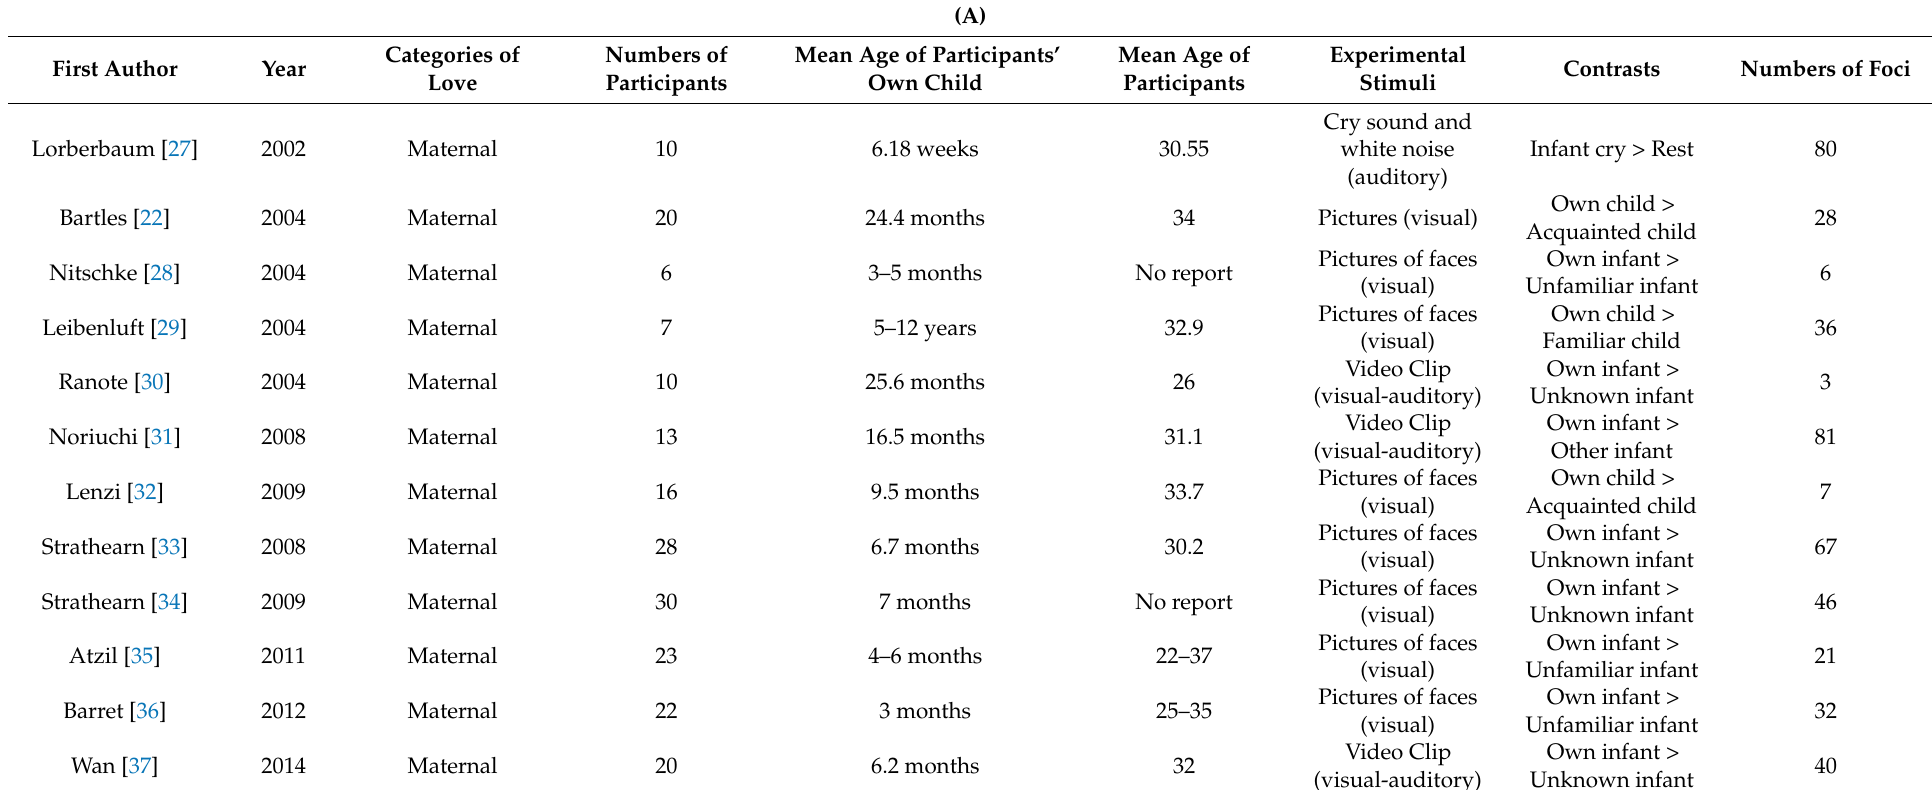
Table 1. ( A ): Details of included studies on maternal love. ( B ): Details of included studies of passionate love.